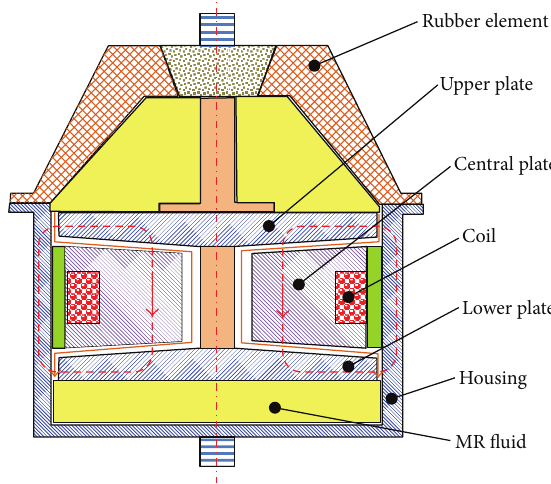
Figure 18: Configuration of MR mount with inclined gaps.